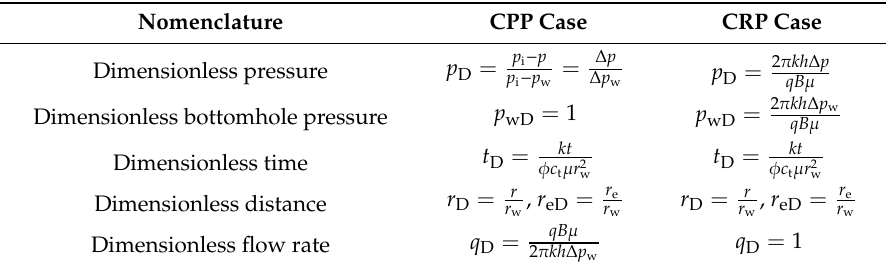
Table 1. Definitions of dimensionless variables for vertical